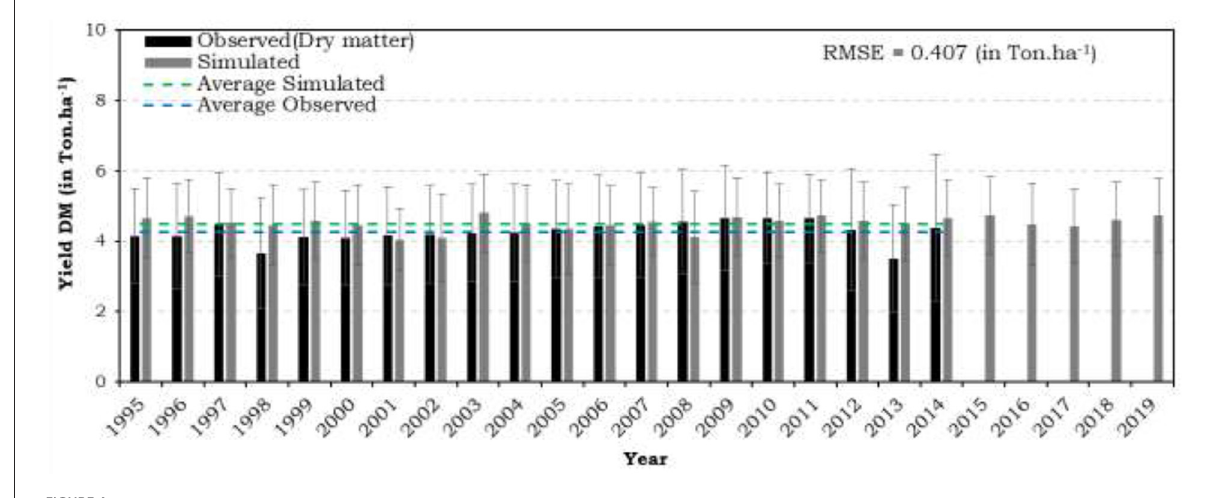
FIGURE4 Annual variation of simulated (nutrient and water-limited) vs. observed (farmer’s yield at the state level in Nigeria) cassava yield (in Ton.ha − 1 ) for 20 years (1995–2015) averaged over 30 states in